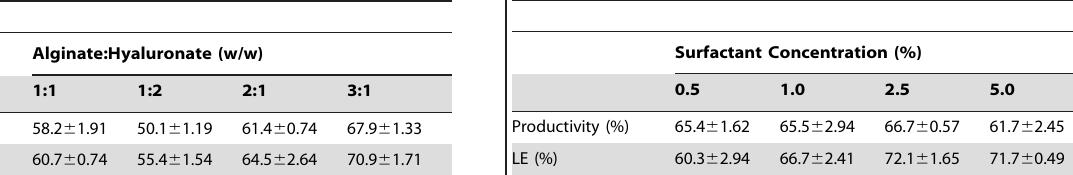
Table 4. Comparision of different surfactant concentration a